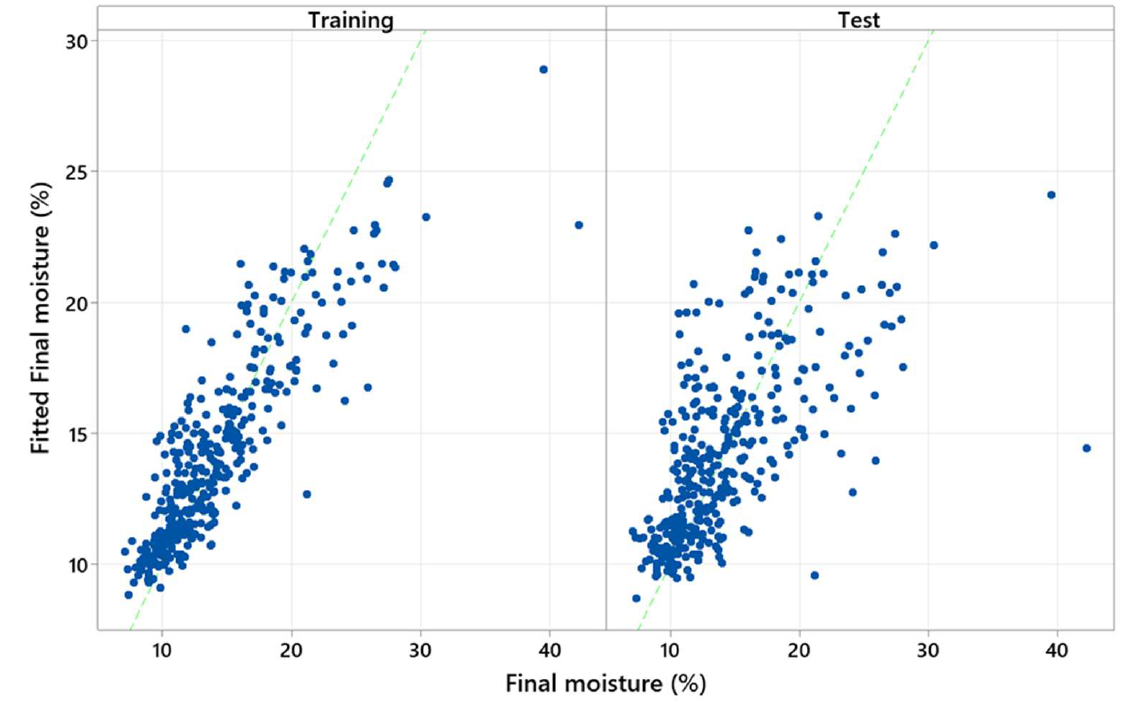
Figure 10. The actual M f against the predicted M f .